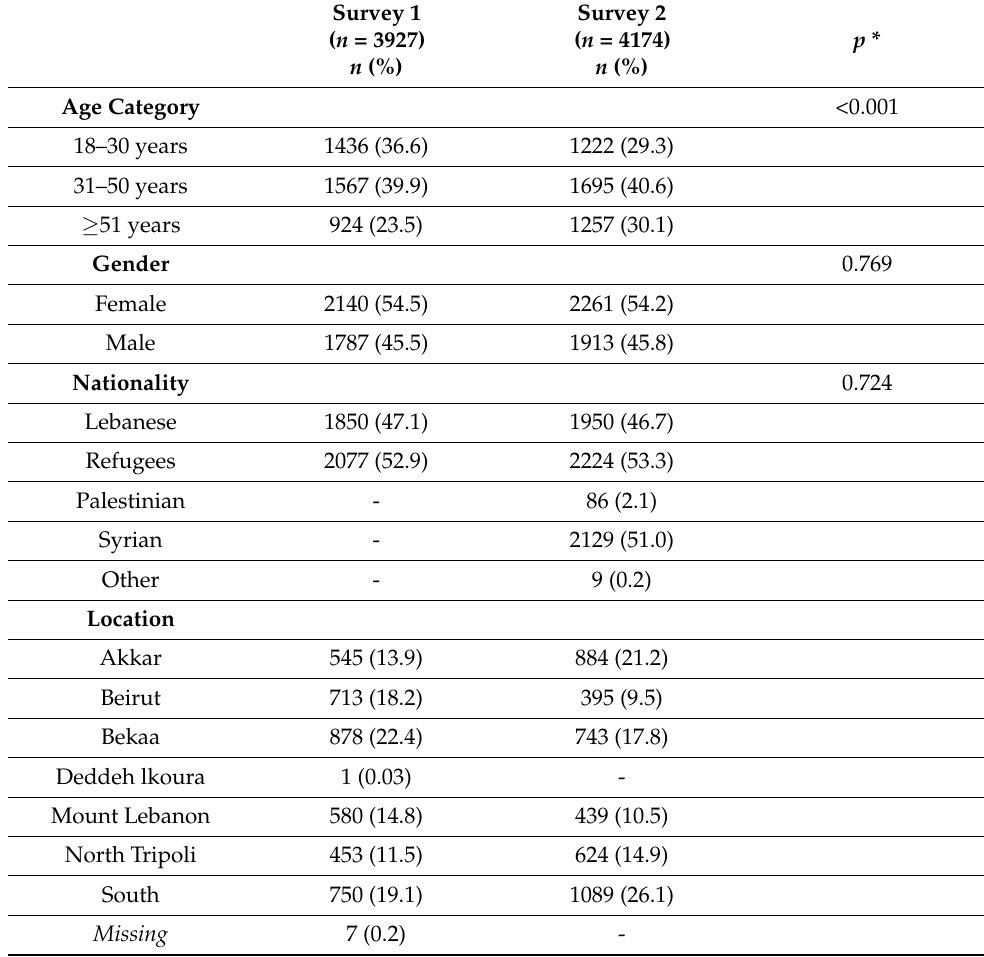
Table 1. Participant